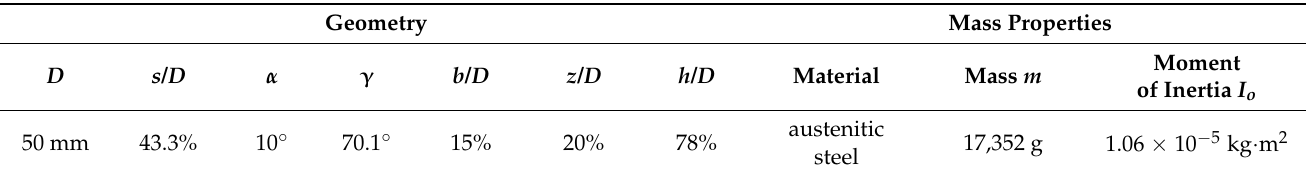
Figure 4. Parameters describing the oscillator’s shape: ( a ) rear view; ( b ) top view.